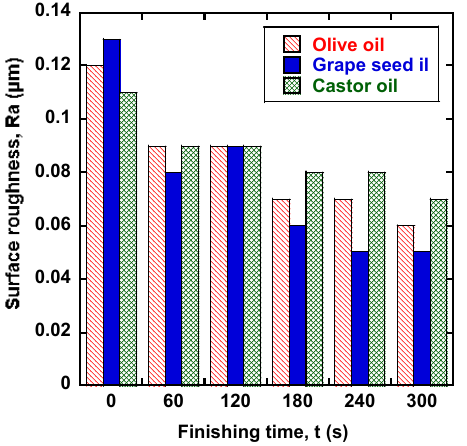
Figure 5. Surface roughness (Ra) vs. finishing time according to the oil used (500 rpm).